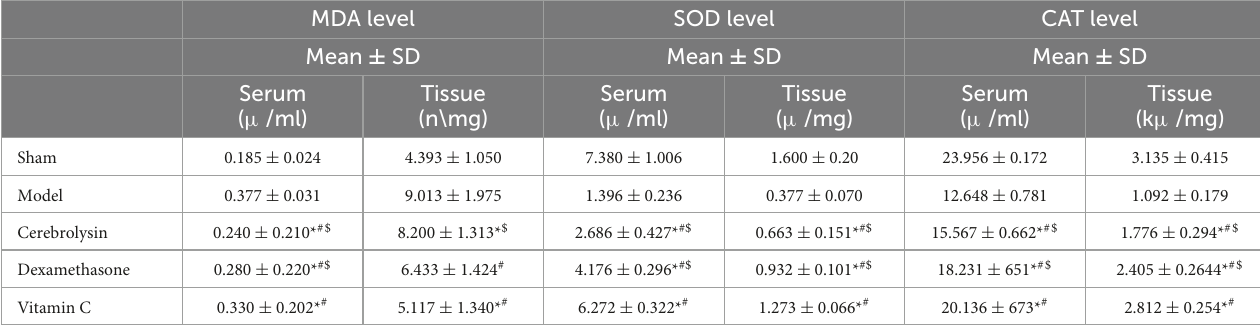
TABLE 1 Mean level of the malondialdehyde (MDA), superoxide dismutase (SOD), and catalase (CAT) in serum and sciatic nerve tissue of rats ± SD in all groups and N = 8 for each group.